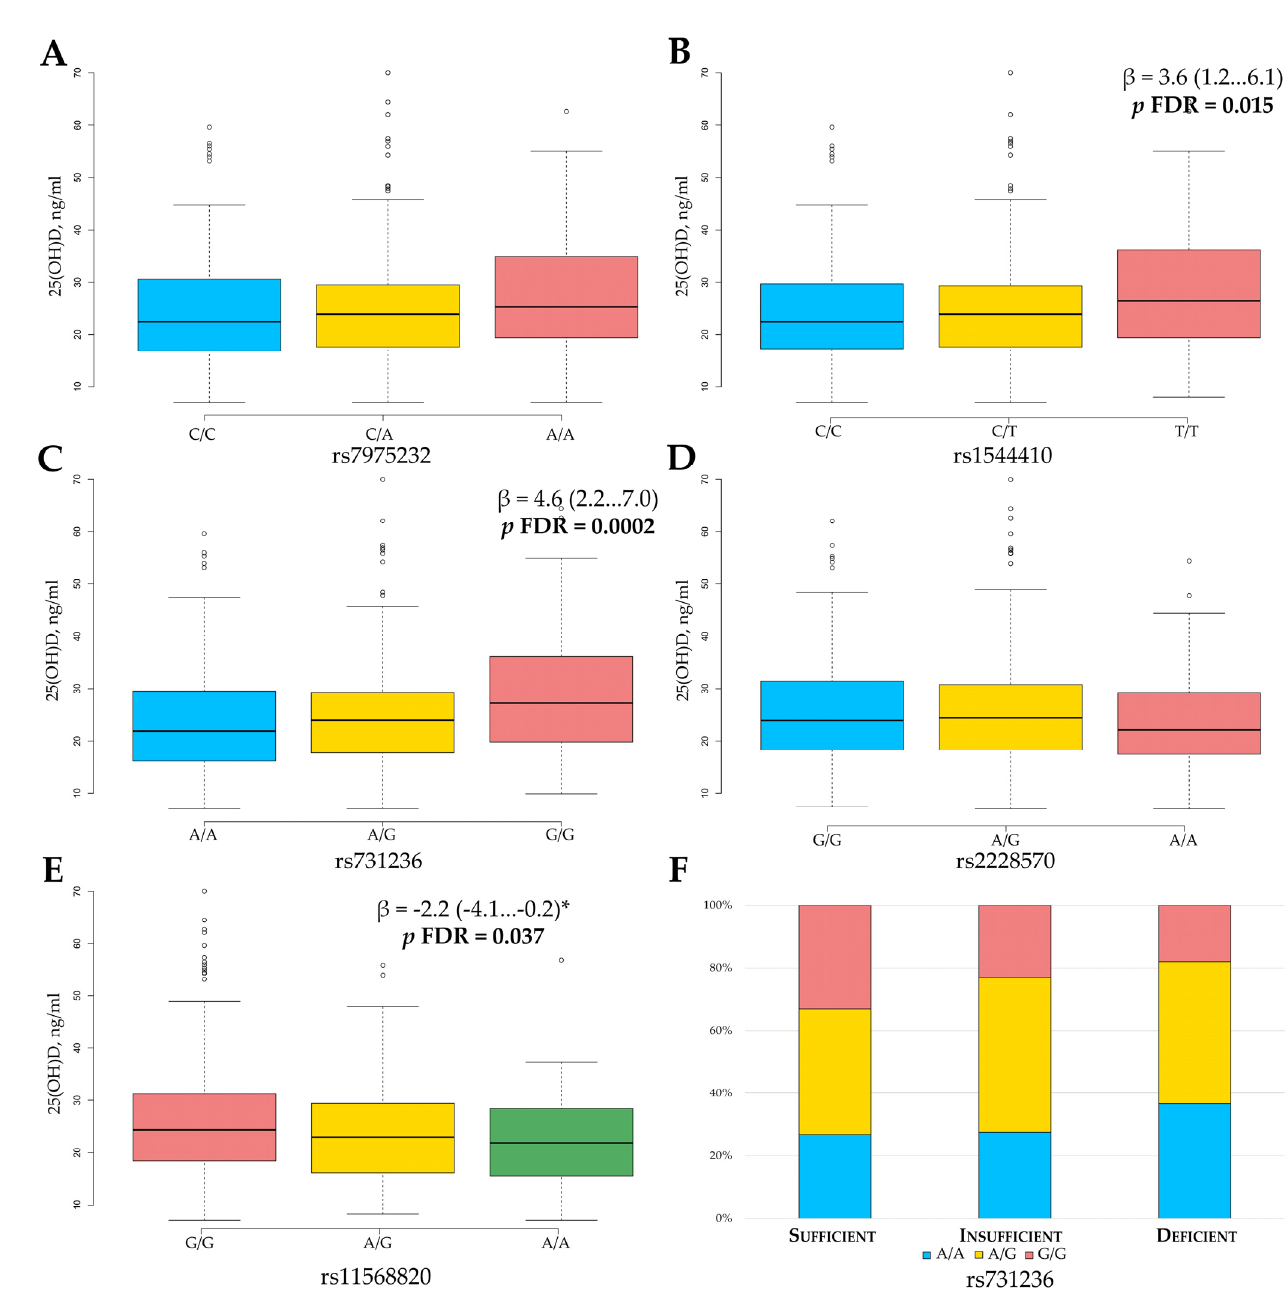
Figure 3. The association of serum 25-hydroxyvitamin D levels with VDR gene variants rs7975232 ( A ), rs1544410 ( B ), rs731236 ( C ), rs2228570 ( D ), rs11568820 ( E ), and rs731236 genotype distribution in groups based on Vitamin D status ( F ). For rs1544410, rs731236, and rs11568820 variants, gene/dose dependence was revealed. The rs11568820 was the only VDR gene variant with protective effect. p -values corrected for multiple testing using the FDR, β is the difference compared to the reference value. The data are presented as β (95% CI). * Dominant model of inheritance.